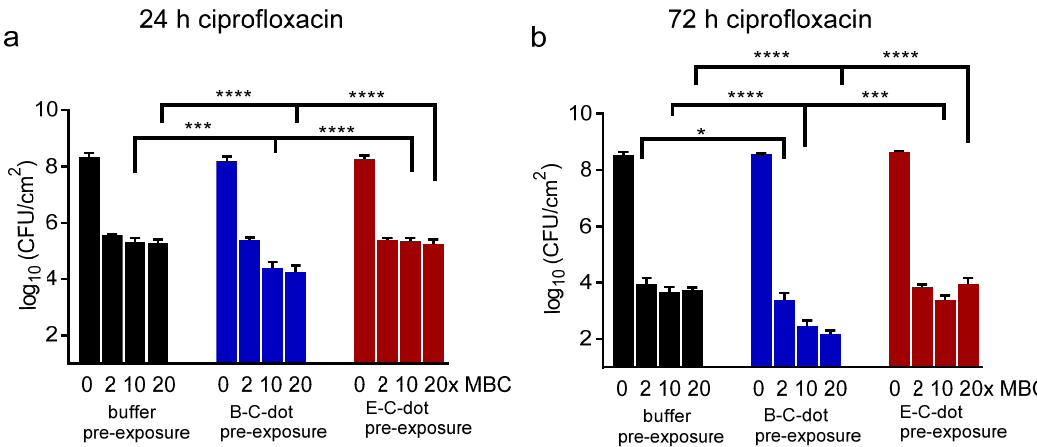
Figure 5. Effects of pre-exposure to C-dots (500 µ g/mL) hydrothermally derived from B. breve ATCC 15700 (B-C-dots) and E. coli ATCC 25922 (E-C-dots) on antibiotic killing in 24 h and 72 h grown E. coli biofilm. Exposure to 10 mM phosphate buffer (pH 7.4) was applied as a control. ( a ) Effects of 24 h ciprofloxacin treatment at different concentrations (indicated in multiples of its MBC, see Table S1) on the number of CFUs in E. coli ATCC 25922 biofilms. ( b ) Same as panel ( a ), now for 72 h ciprofloxacin treatment. All data are expressed as means ± standard deviations over triplicate experiments with separately prepared C-dots and different E. coli cultures. * p < 0.05, *** p < 0.001 and **** p < 0.0001 indicate significant differences with respect to pre-exposure to buffer or different C-dot suspensions (one way